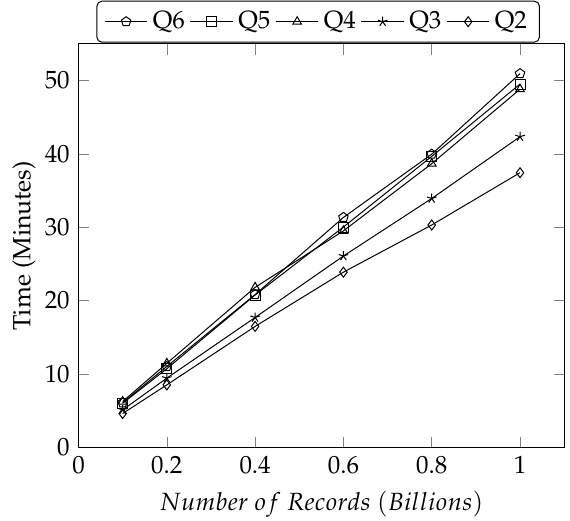
Figure 8. Scalability against the # of QID .